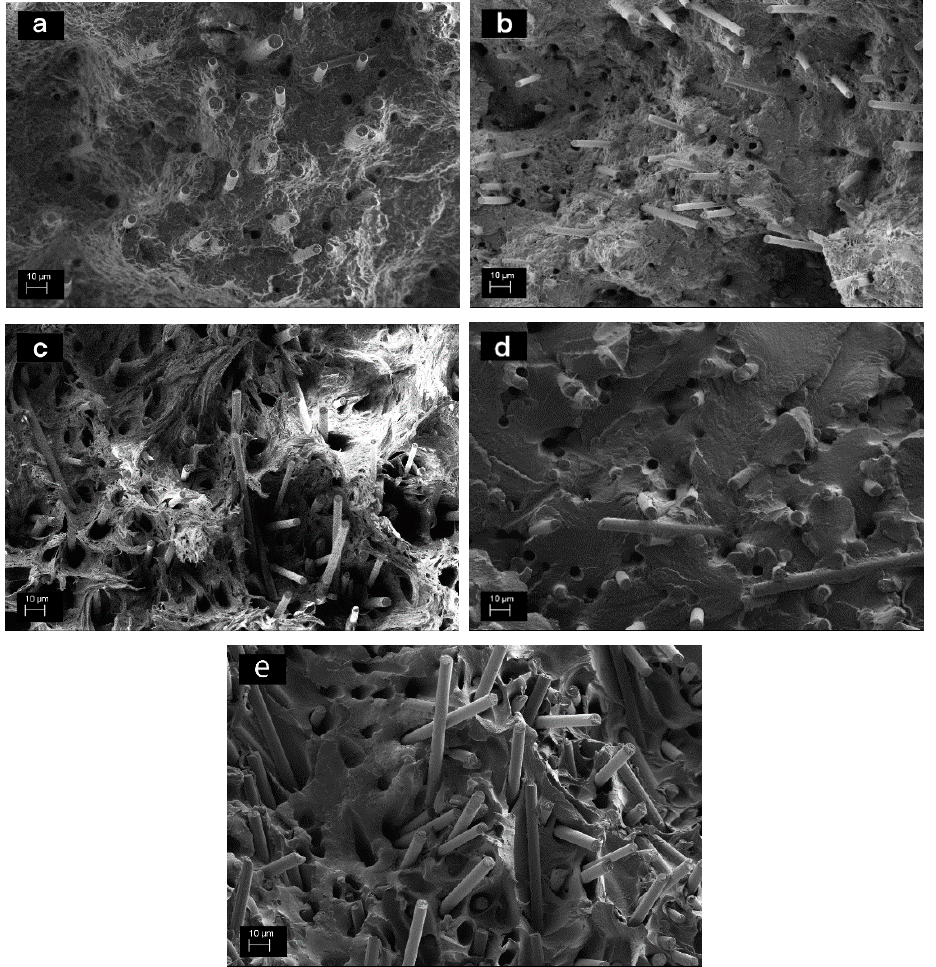
Figure 8. Fracture surfaces of ( a ) rCF-PP compound without any fibre surface treatments, ( b ) rCF-PP with 5-% sizing, ( c ) rCF-PP acid treatment with 5 w-% sizing, ( d ) rCF-PA6 without any treatment and ( e ) rCF-PA6 with 5-% sizing.